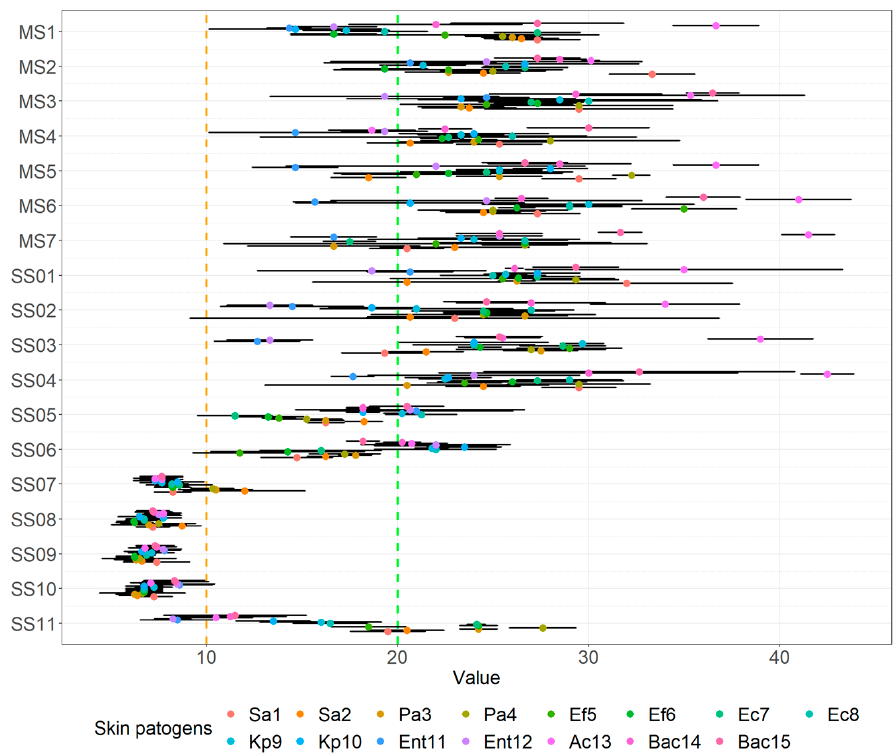
Figure 2. Means of inhibition zone together with 95% CI of various probiotics and other beneficial microbes against clinical skin pathogens using the agar spot assay.